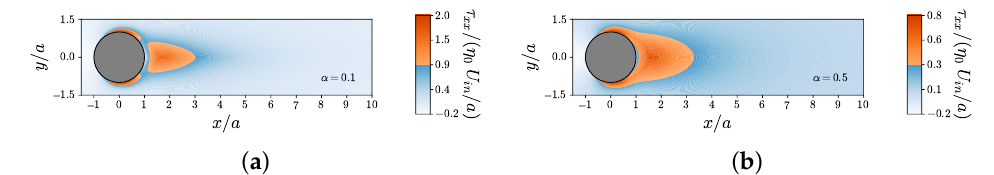
Figure 8. Contours of the dimensionless normal component of the polymeric extra-stress tensor τ xx for the shear thinning Giesekus viscoelastic fluid at fixed Re = 1, Wi = 2, ζ = 0.5 and different values of mobility parameter: ( a ) α = 0.1 and ( b ) α =